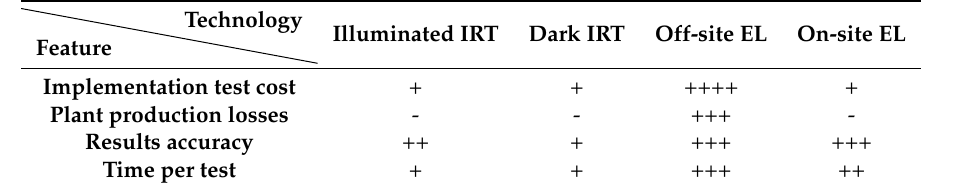
Table 3. Features and costs comparison between state of the art and proposed USPVP image processing